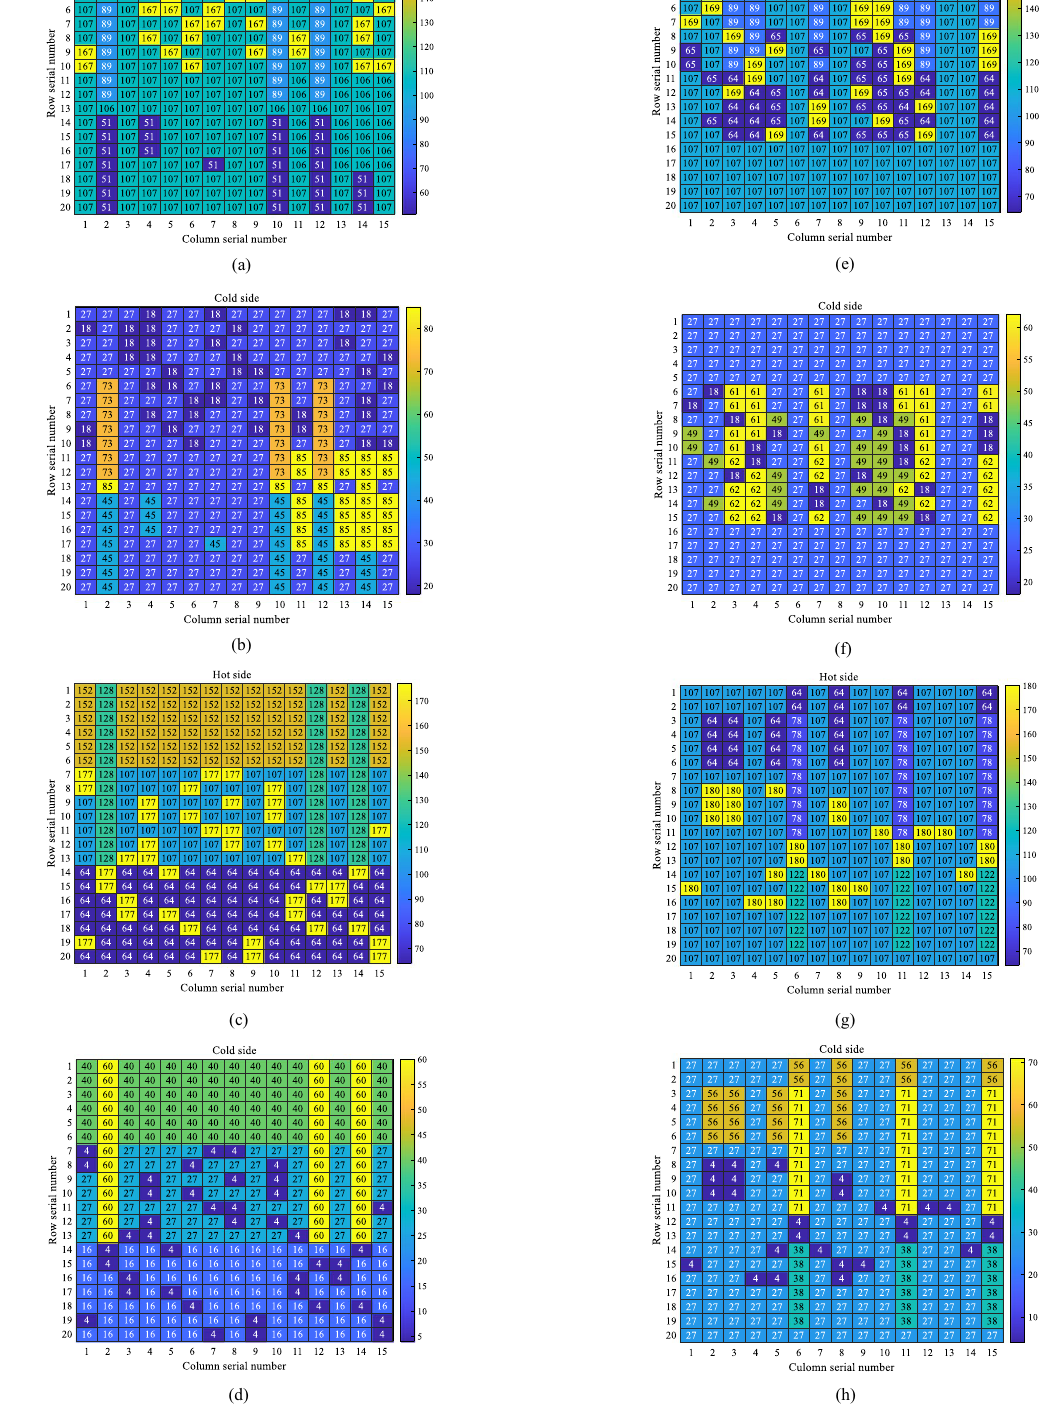
15) optimized by ACS: a , b diagonal, c , d outer, e , f inner, g , h ×